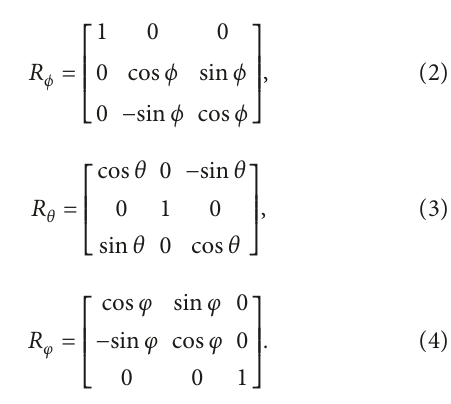
Figure 1: Diagram of quadrotor